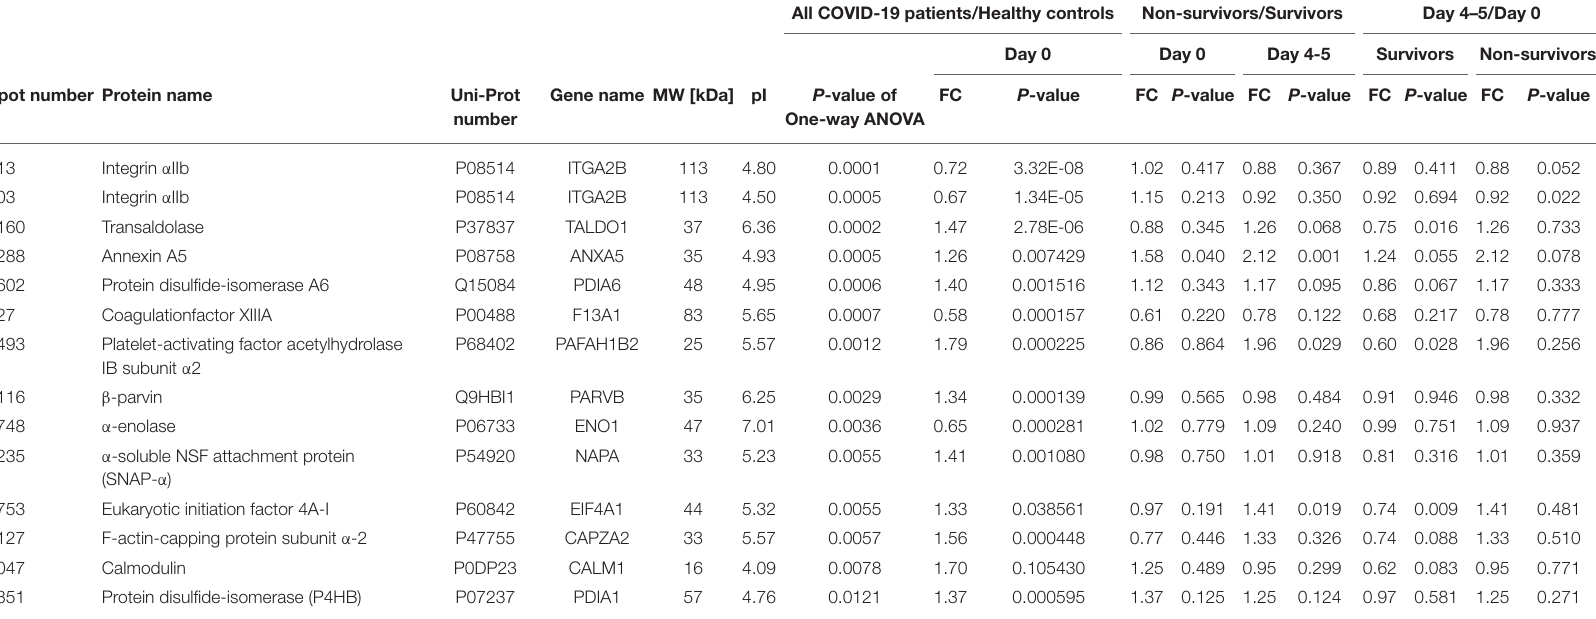
TABLE 3 | 2D-DIGE-identified proteome alterations in platelets from COVID-19 patients compared to healthy